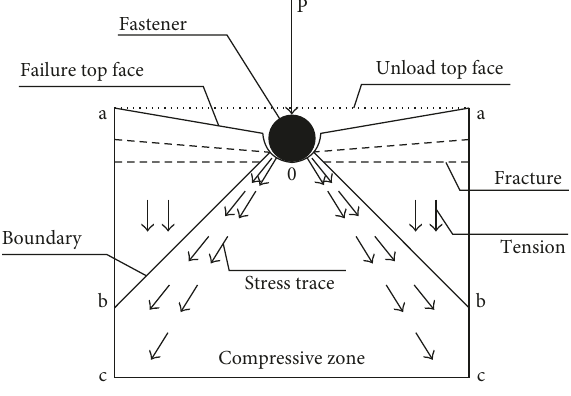
Figure 5: Stress state of the